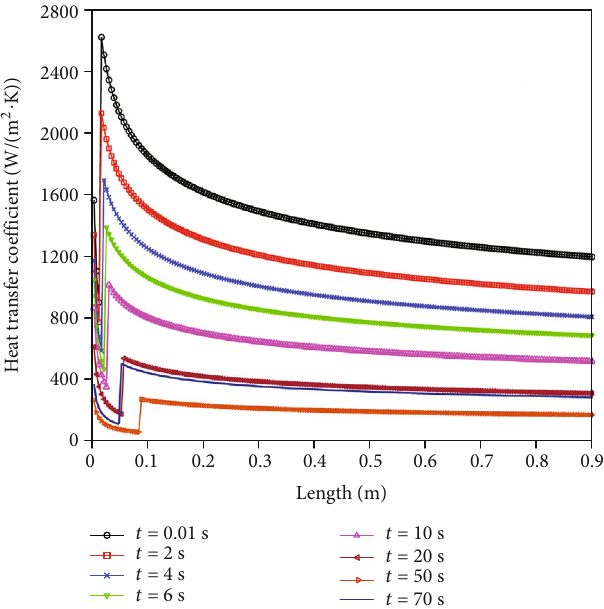
Figure 8: Transient heat transfer coe ffi cients.